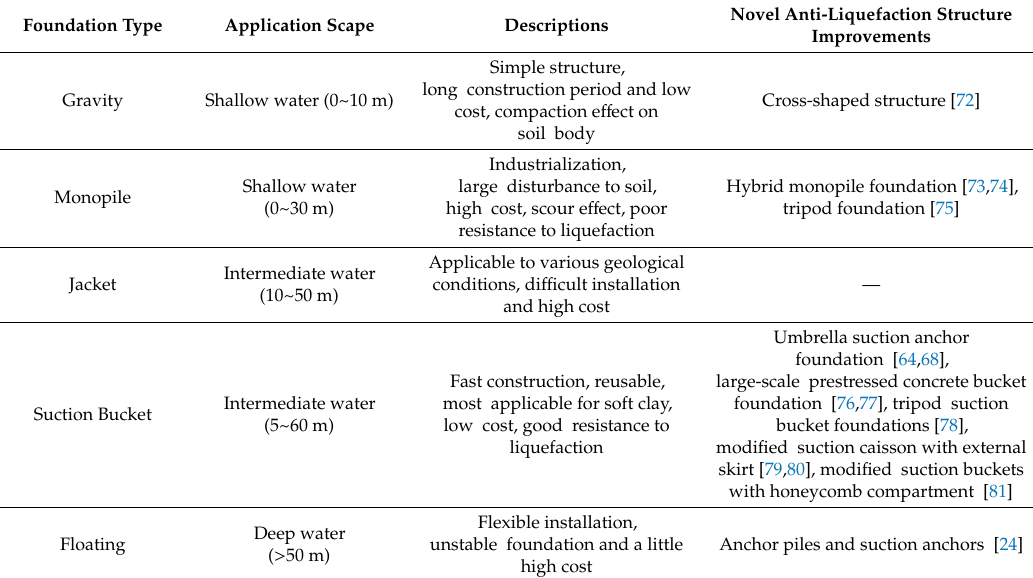
Table 2. Main OWT foundation types and novel liquefaction-resistant structure improvements (based on [2,26,68–71]).